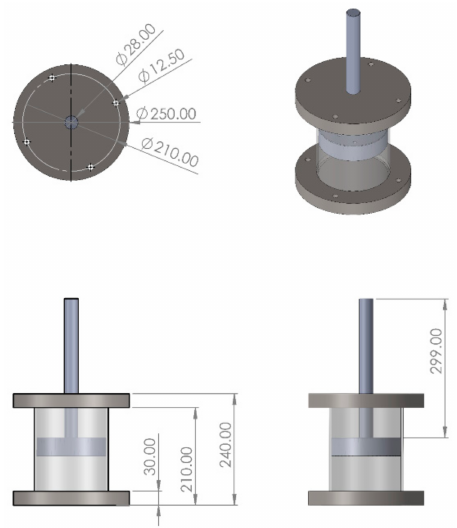
Figure 4. The schematic diagram of the whole designed oedometer cell after